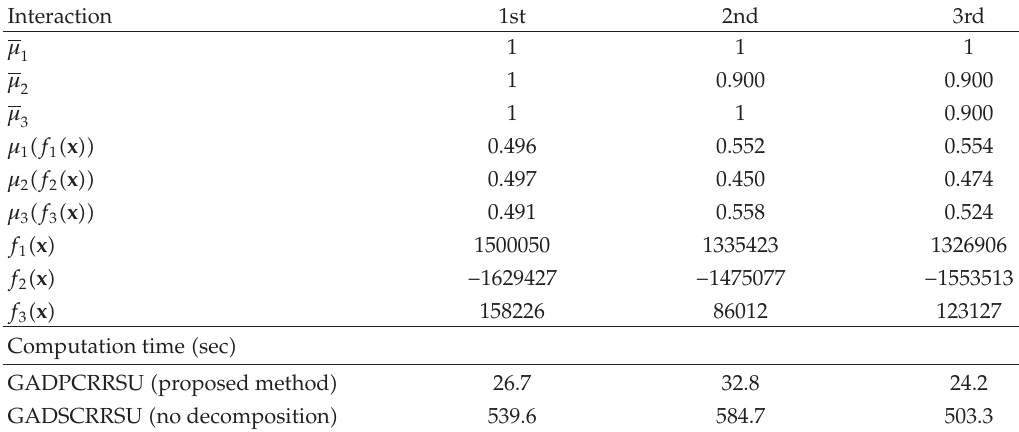
Table 1: The whole process of